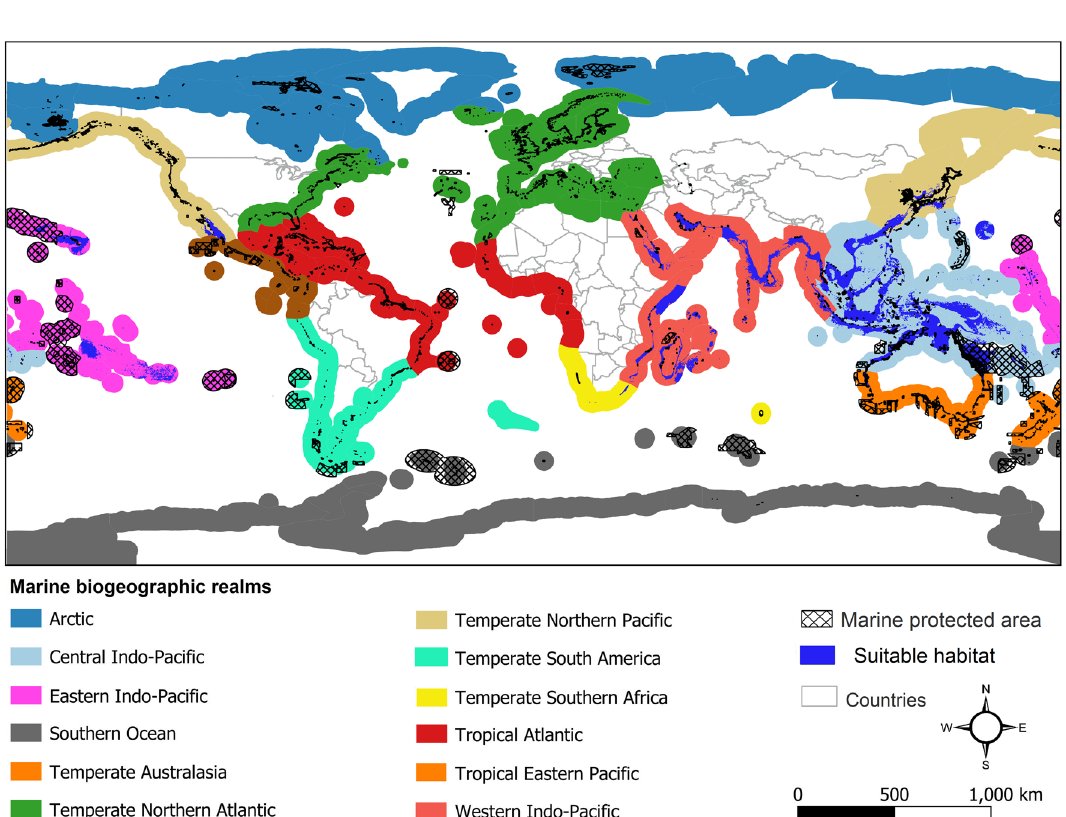
Figure 2. Protected areas coverage for suitable habitats of the Metopograpsus thukuhar / cannicci species complex based on marine biogeographic realms. Map was generated using QGIS 3.4.1 (https:// www. qgis.